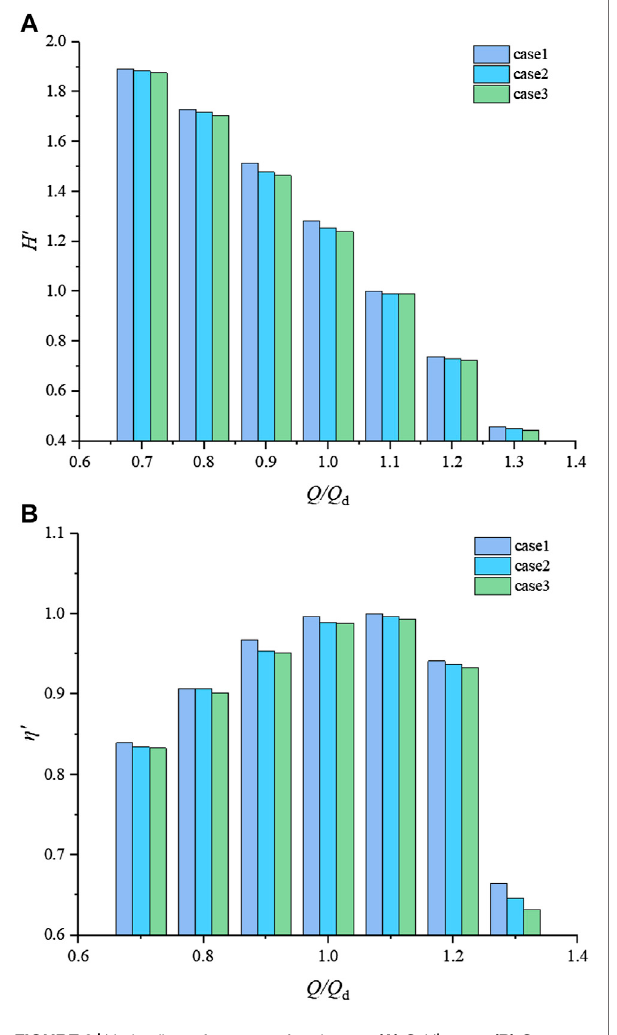
FIGURE 6 | Hydraulic performance of each case. (A) Q - H ′ curve. (B) Q - η ′ curve.